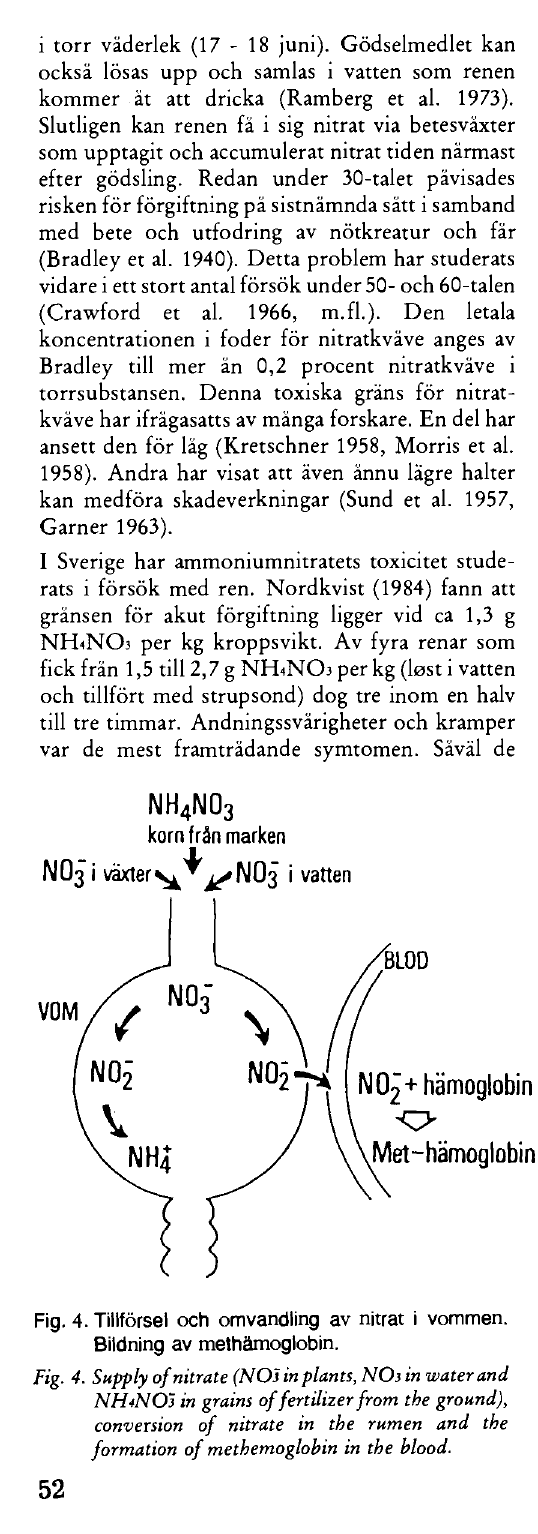
Fig. 4. Tillforsel och omvandling av nitrat i vommen. Bildning av methåmoglobin. Fig. 4. Supply of nitrate ( NOJ in plants, NO3 in water and NH4NO3 in grains of fertilizer from the ground), conversion of nitrate in the rumen and the formation of methemoglobin in the